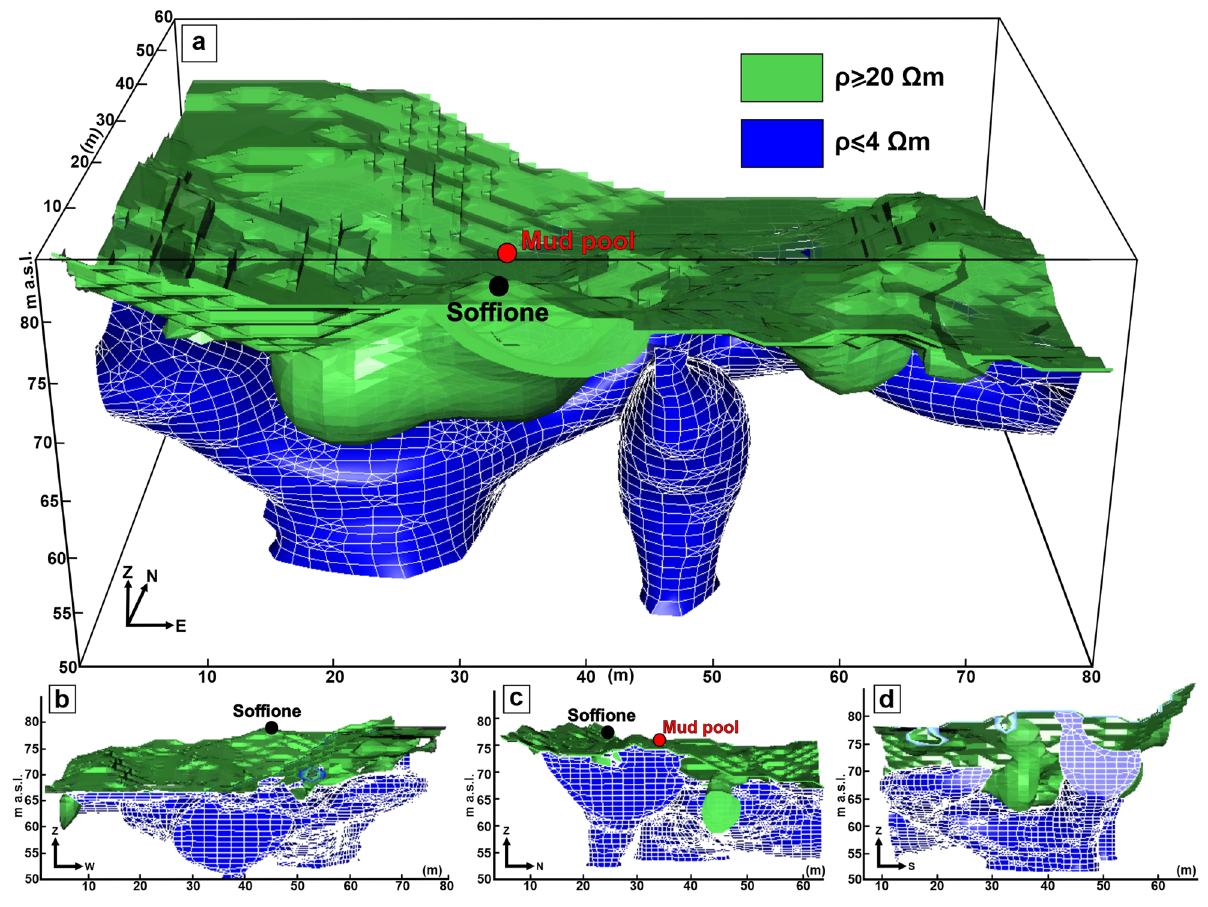
Figure 2. Sketches of the 3D resistivity model in four different views. The proposed visualizations are based on an isovolumetric representation of the electrical resistivity distribution reconstructed through the ERT survey. The volume resolved by tomography is divided into three parts: a high-resistivity volume (HRV, in green, where ρ ≥ 20 Ω·m), a medium-resistivity volume (MRV, omitted for a better graphical representation, where 4 Ω·m < ρ < 20 Ω·m), and a low-resistivity volume (LRV, in blue, where ρ ≤ 4 Ω·m). The figure was created using the Visit 3.1.2 open-source software (https:// wci. llnl. gov/ simul ation/ compu ter- codes/ visit) produced by the Lawrence Livermore National Laboratory (USA) and postprocessed using the Corel Draw 17 commercial software (https:// www. corel draw. com/ it/ produ ct/ corel